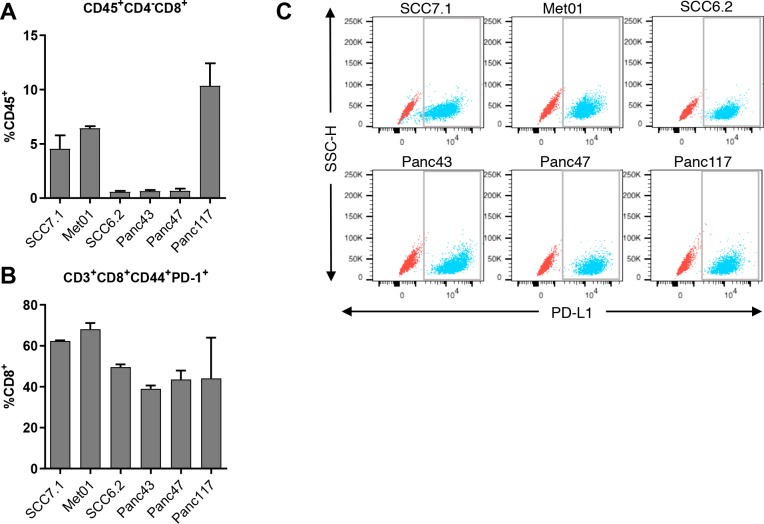
Regulation of PD-L1/PD-1 axis does not correlate with response of tumors to BI 853520.(A) Flow cytometry analysis of CD8+ T-cell infiltration in SCC7.1, Met01, SCC6.2, Panc43, Panc47, and Panc117 tumors. (B) Flow cytometry quantification of the percentage of CD8+ T-cells expressing PD-1 in SCC7.1, Met01, SCC6.2, Panc43, Panc47, and Panc117 tumors. (C) Flow cytometry analysis of PD-L1 expression on SCC7.1, Met01, SCC6.2, Panc43, Panc47, and Panc117 cells following stimulation with 10 ng/ml IFNγ for 24 hr under normal culture conditions. (A and B) Data represented as mean + /- s.e.m, n = 3.